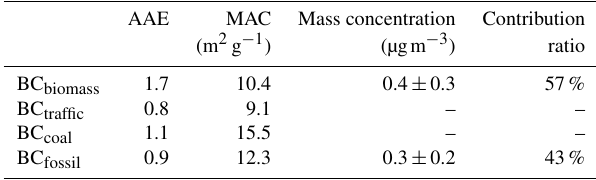
Table 1. Derived Ångström absorption exponents (AAEs), mass absorption coefficients (MACs) and percent source contribution of black carbon (BC) from difference